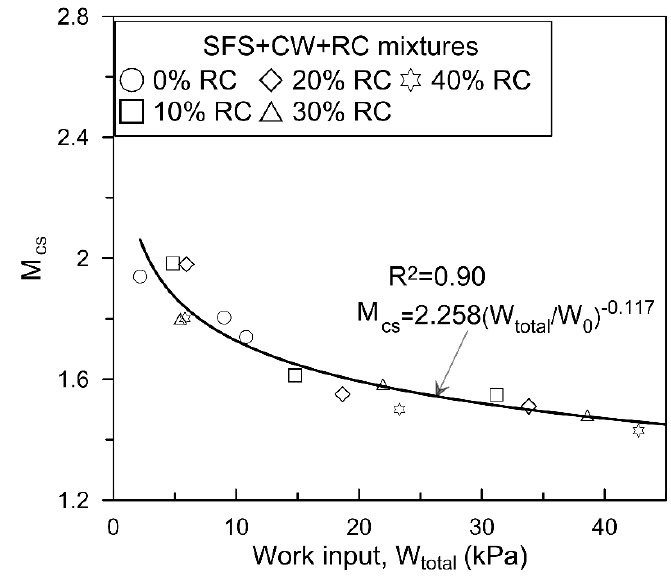
Figure 6. The relationship between 𝑊 (cid:3047)(cid:3042)(cid:3047)(cid:3028)(cid:3039) and 𝑀 (cid:3030)(cid:3046) (modified after Qi et al. [43]).